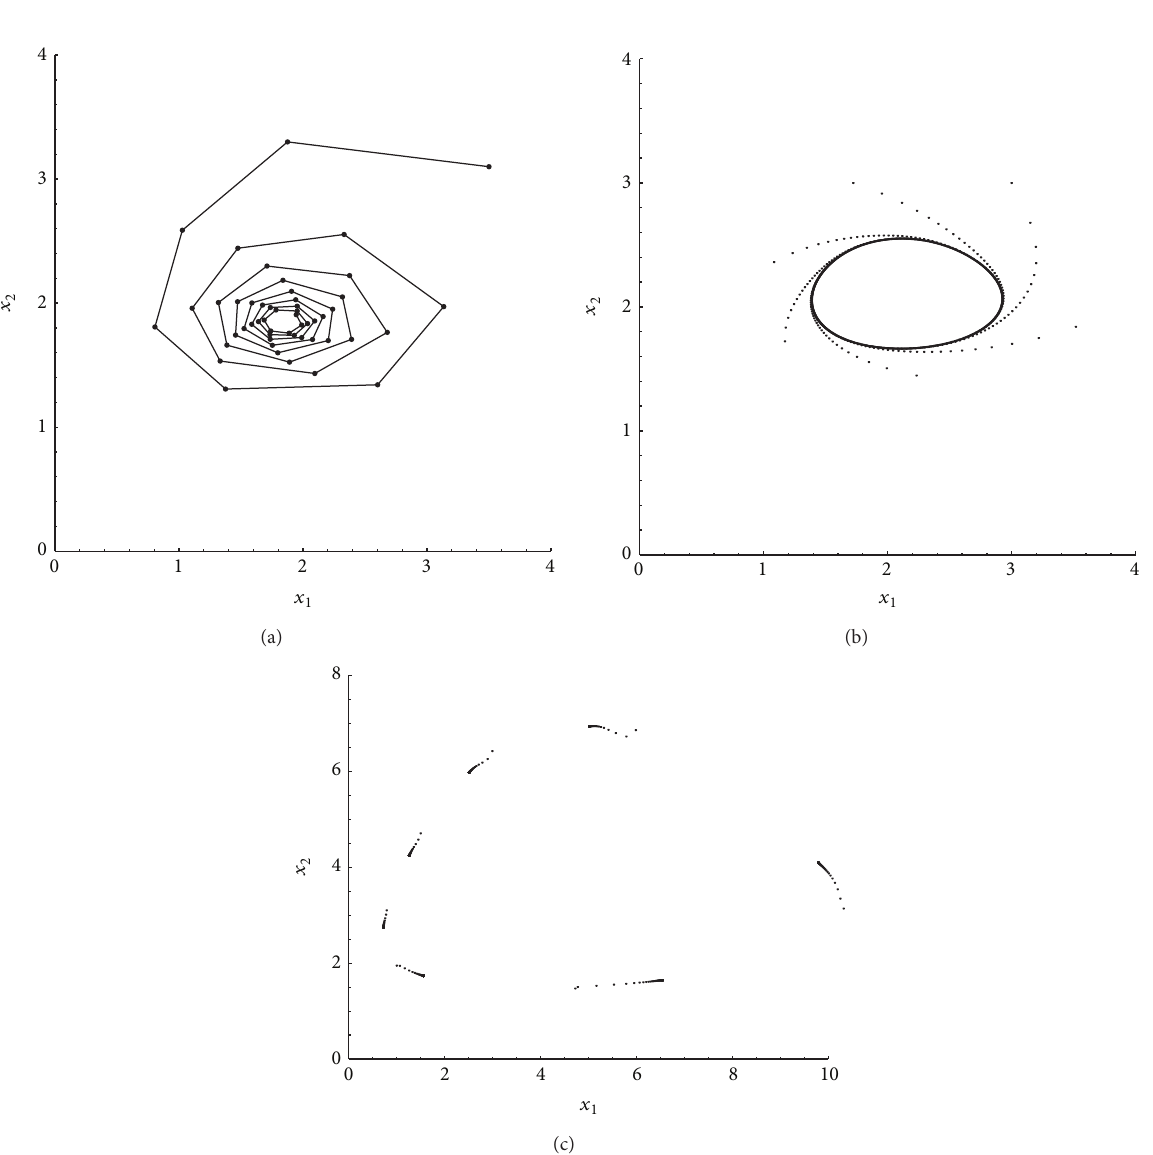
Figure 1: (a) An orbit converging towards the stable equilibrium. Parameter values 𝛽 1 = 2 , 𝛽 2 = 0 , 𝐹 = 20 , and 𝜇 1 = 𝜇 2 = 0.5 . (b) A stable attractor generated by (1) and (2). Parameter values as in (a) except 𝐹 = 30 . (c) The invariant curve has broken up. Parameter values as in (a) and (b) except 𝐹 = 107